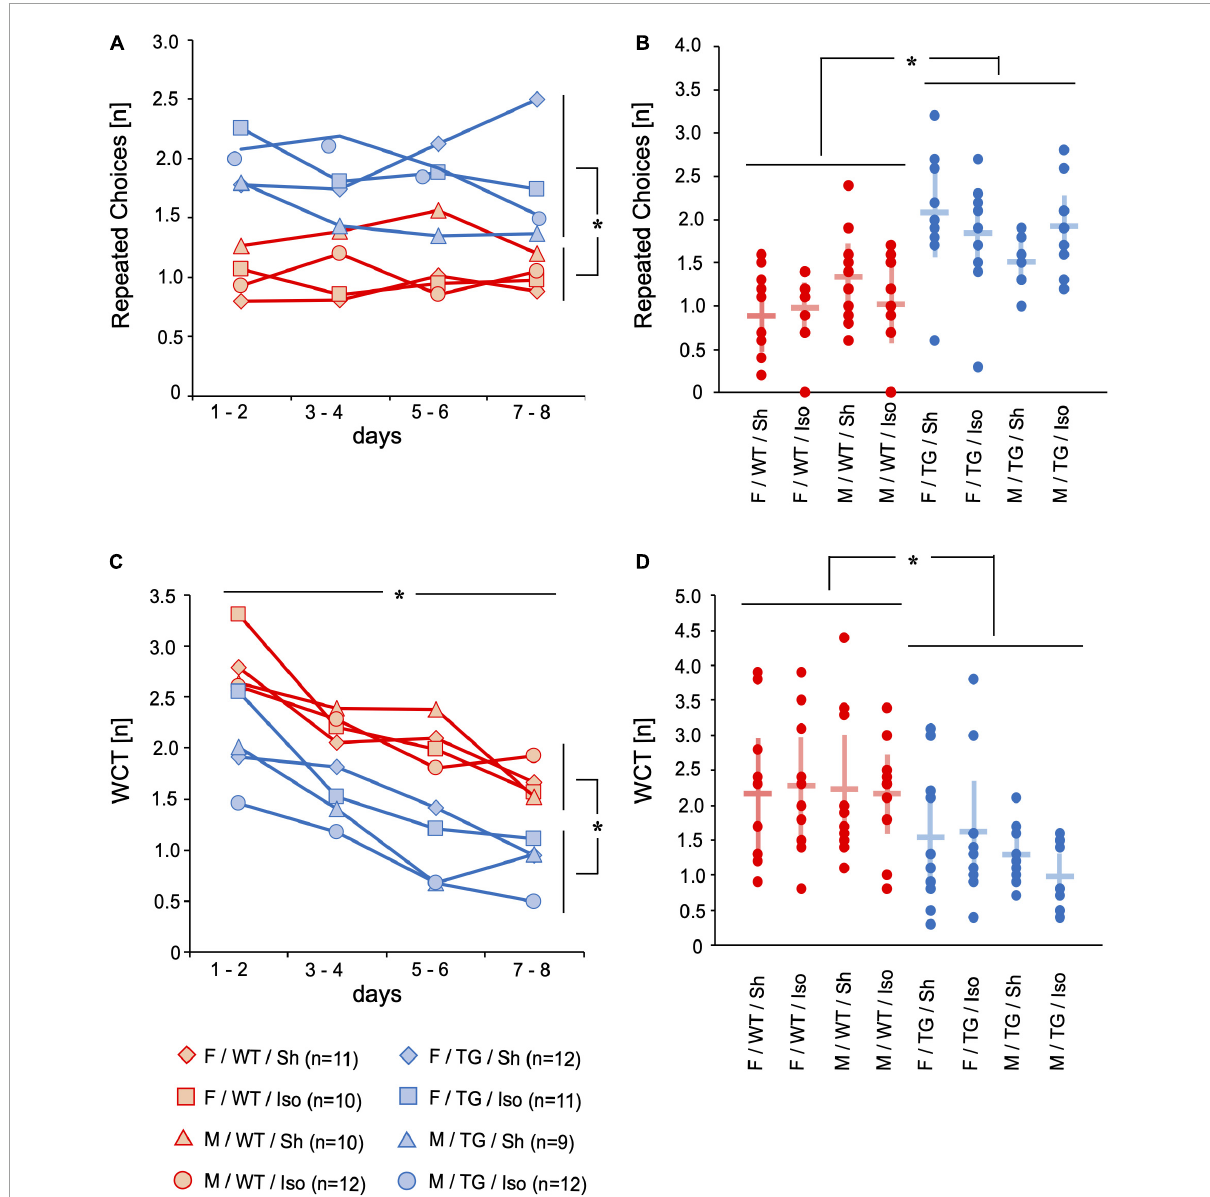
FIGURE2 Repeated choices (RC) [n] and wrong choices total (WCT) [n]. Mean of 4 trials per day on 2 days over time (A,C) and mean and 95%-confidence interval of 4 trials per day on all 8 consecutive days (B,D) sorted by group. RC were higher in Tg2576 compared to WT on days 7–8 and over all days. WCT decreased over 8 days of testing. WCT were lower in Tg2576 compared to WT on days 7–8 and over all days. F, female; M, male; WT, wildtype (red); TG, Tg2576 (blue); Sh, sham procedure; Iso, isoflurane anesthesia. * p <